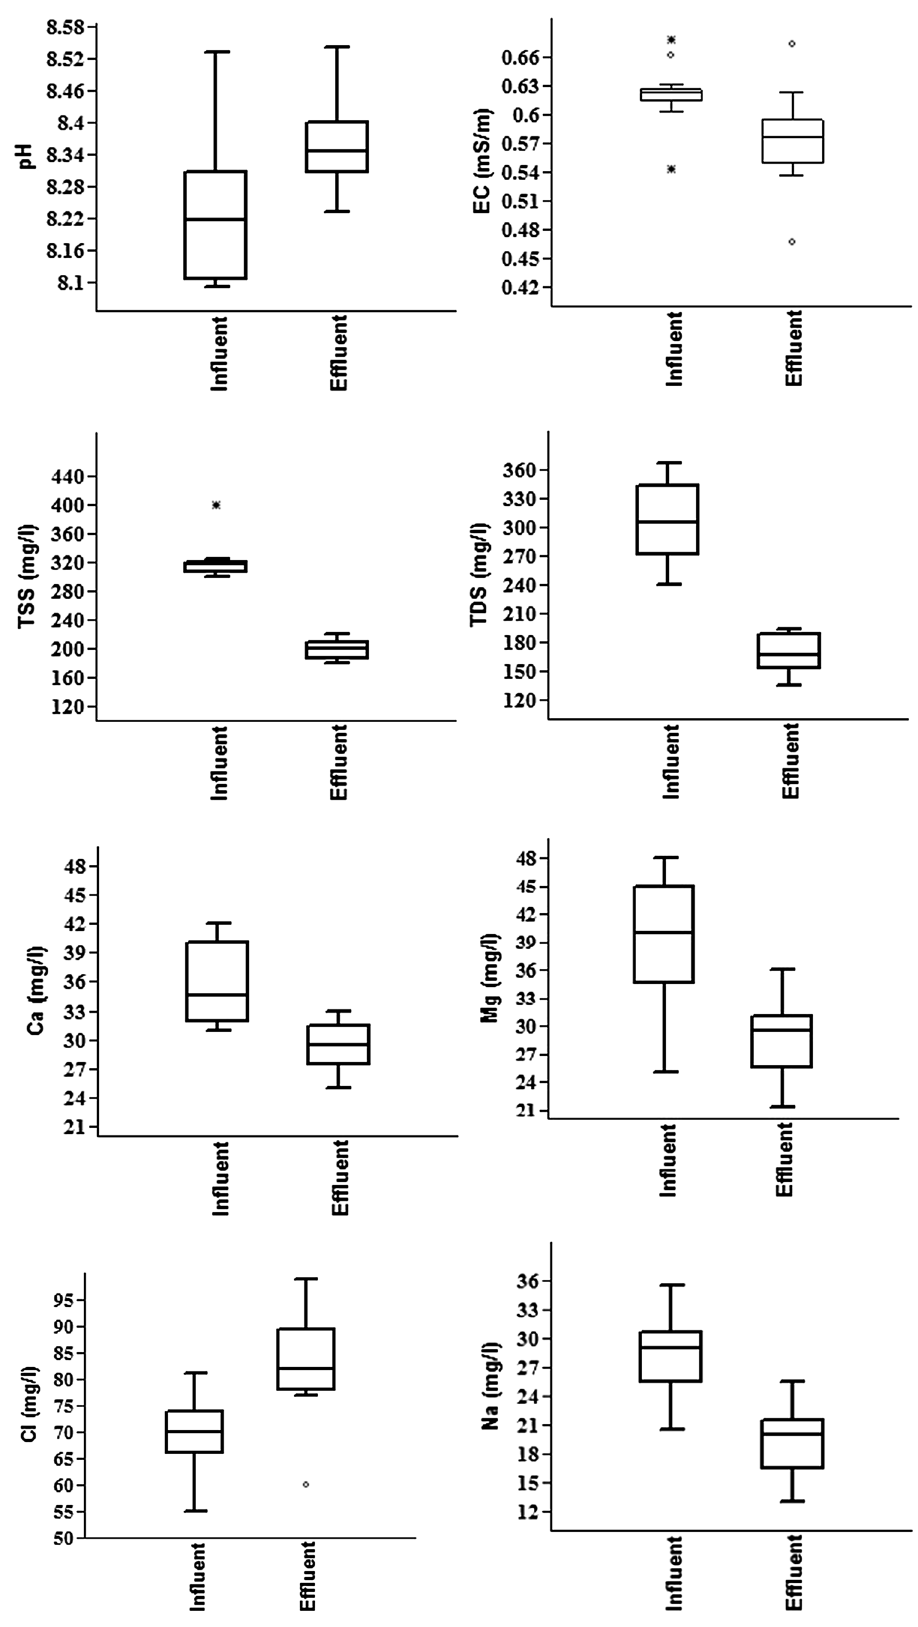
Fig. 1 Box-and-whisker plots of physiochemical characteristics of influent and effluent (open circles and asterisk denote outli- ers with 1.59 interquartile range (IQR) and 3IQR,